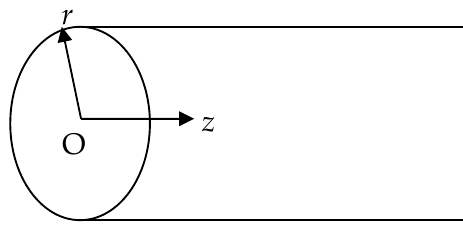
Figure 1. Schematic of the cylindrical microcapillary and the coordinate system used for modeling.